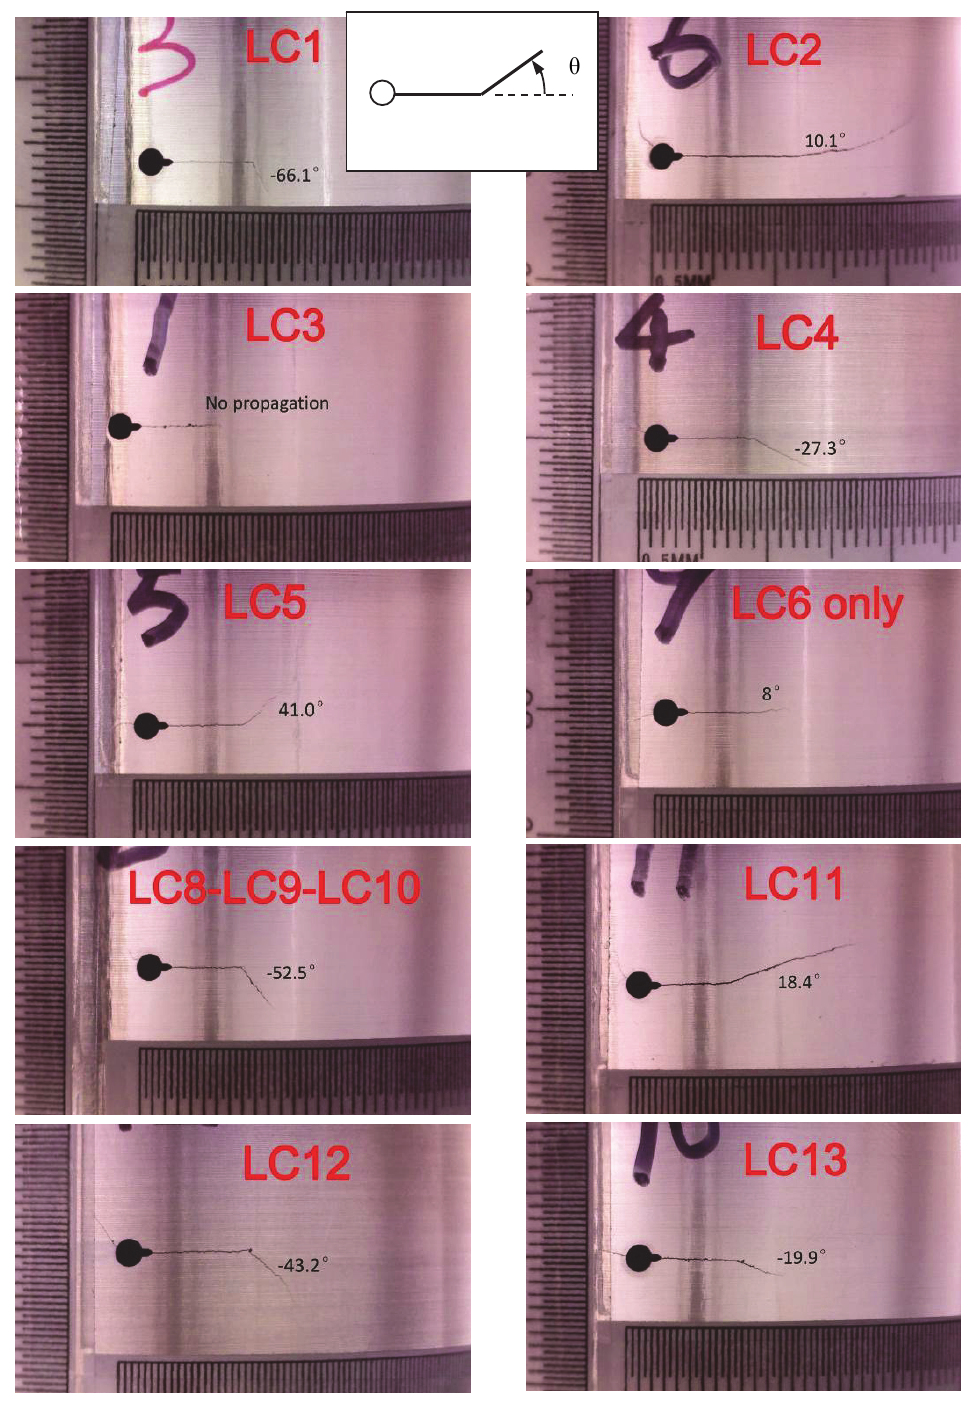
Figure 4: Fatigue cracks at the outer surface of tubular specimens at the end of